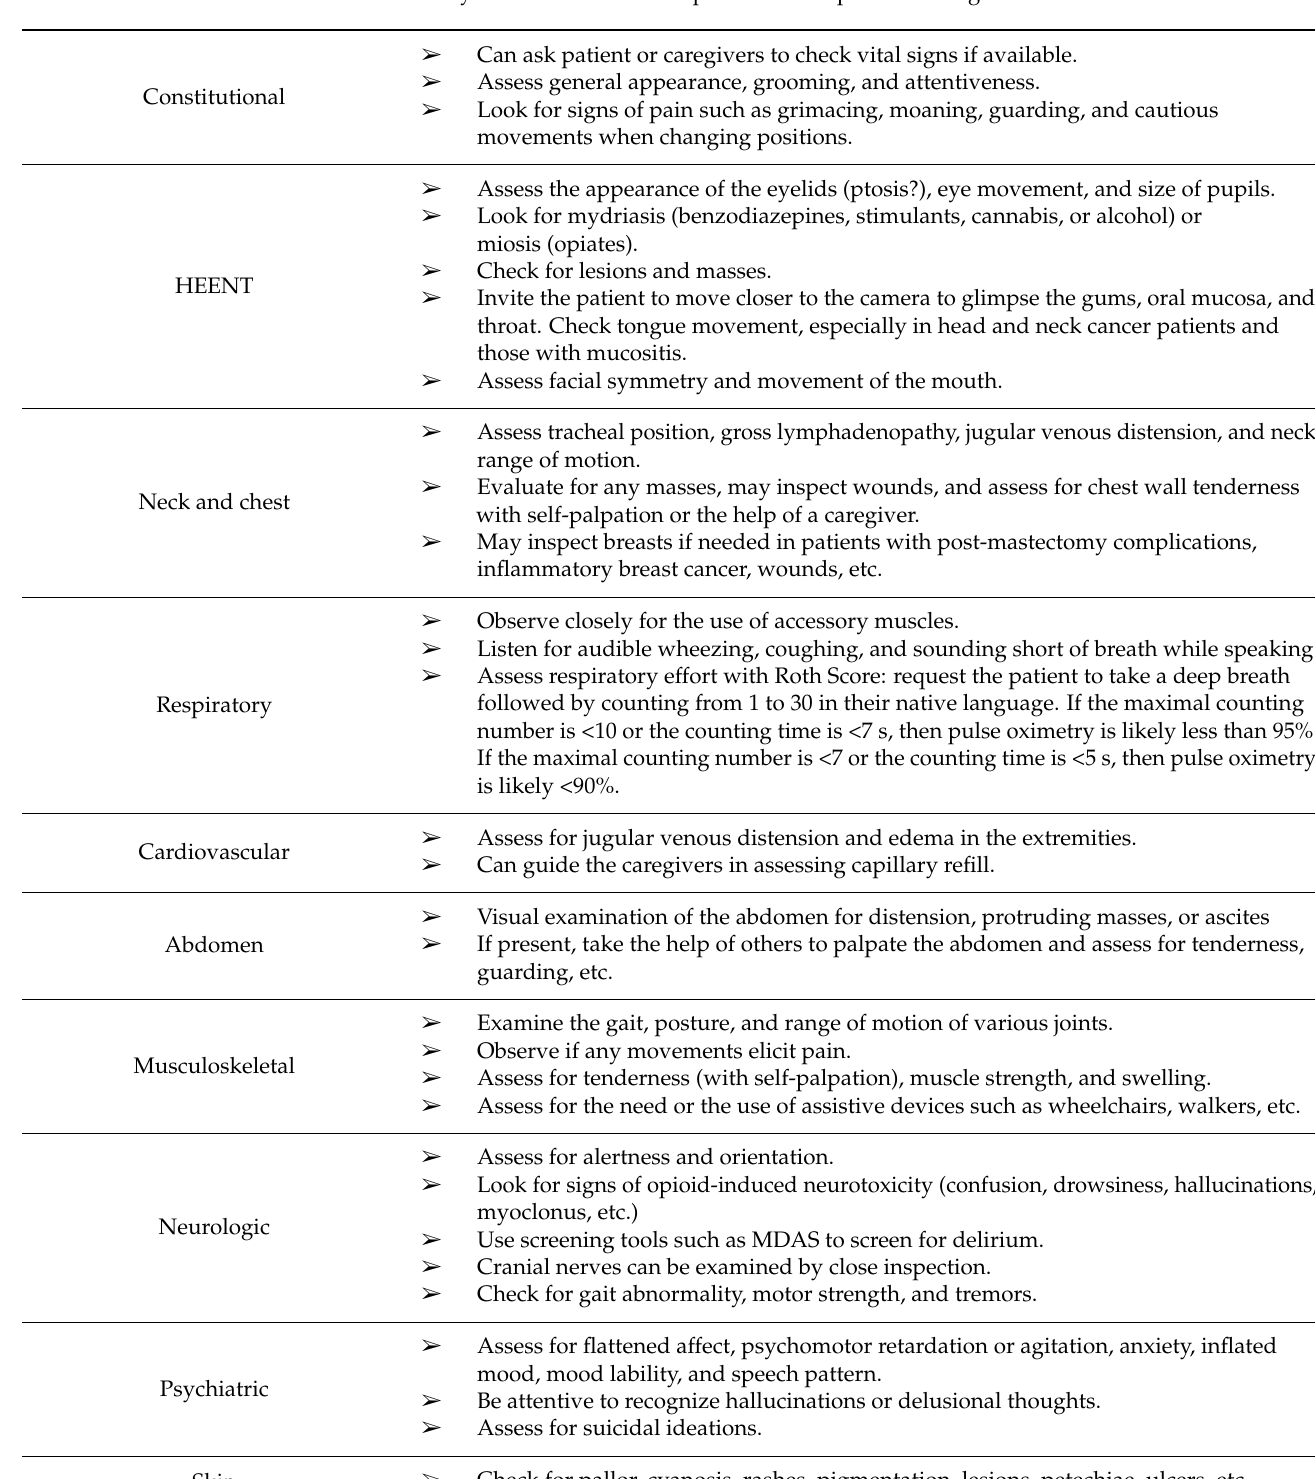
Table 2. Physical examination of a palliative care patient during a